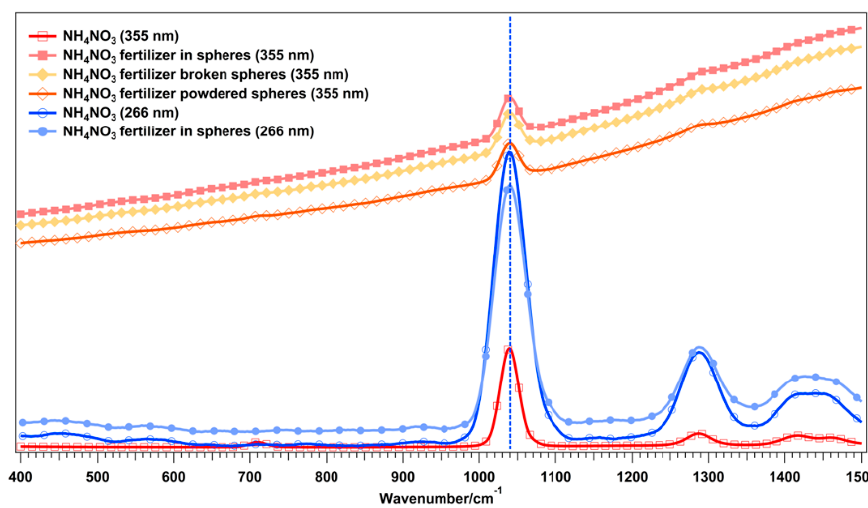
Figure 7. Raman spectra of ammonium nitrate and ammonium nitrate in prills (fertilizer) acquired using 266 nm and 355 nm as exciting laser.